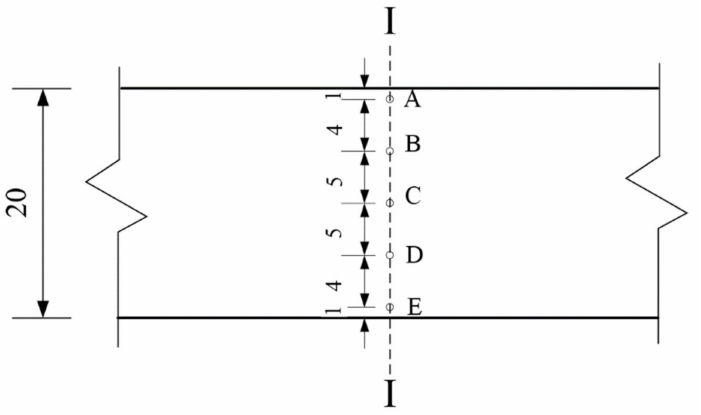
Figure 5. Reference points position